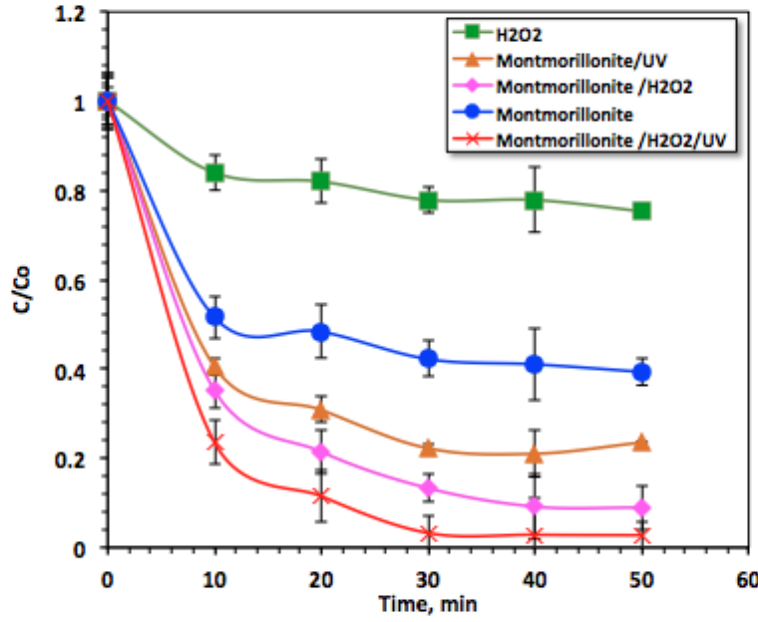
Figure 3. Effects of different oxidation systems on Lanox 90 elimination.